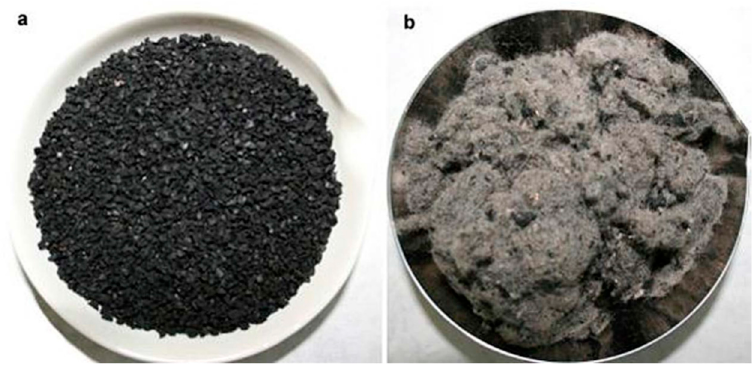
Figure 4. General aspects of the waste tire after shredding: ( a ) crumb rubber particles (1–10 mm) and ( b ) the reinforcing fibers (reproduced with permission from [54]).